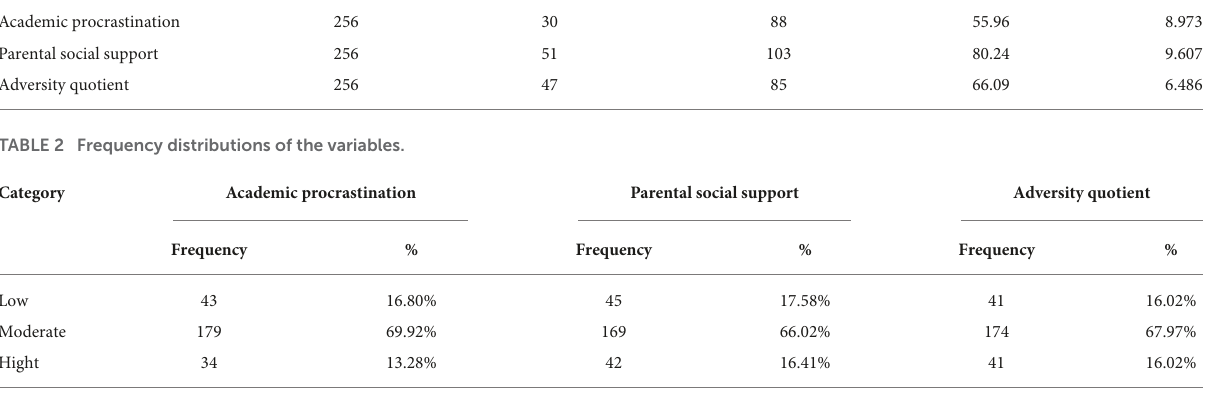
TABLE 3 Model goodness of fit